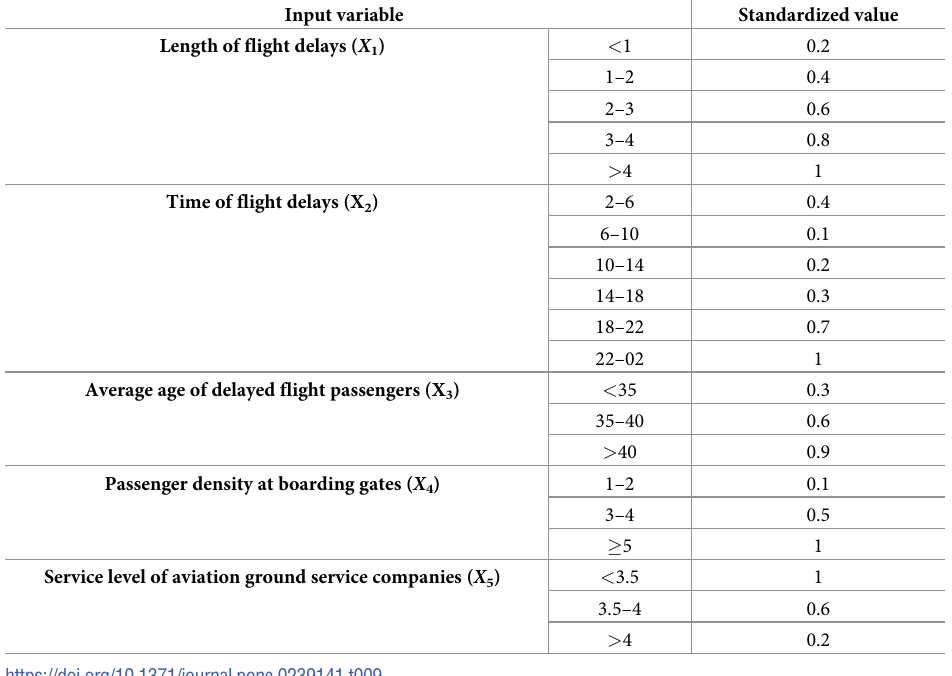
Table 9. Data standardization of BP neural network input layer.